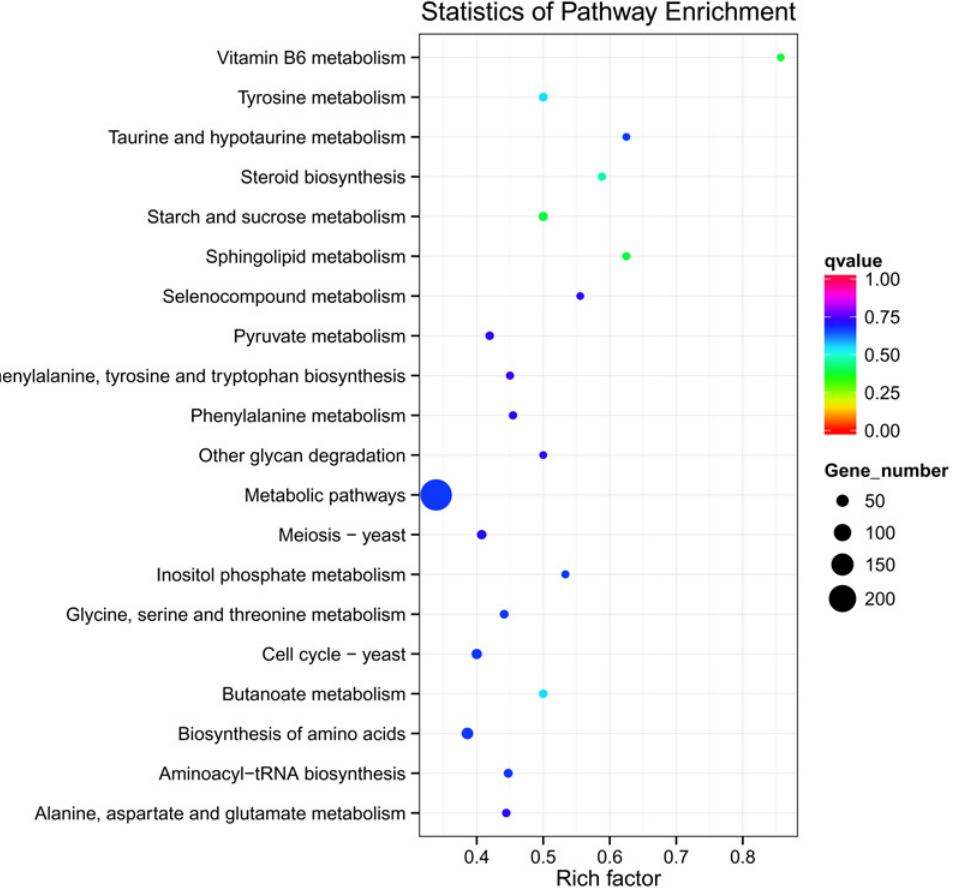
Fig 4. Statistics of KEGG pathway enrichment. The y-axis corresponds to KEGG Pathway, and the x-axis shows the enrichment factor. The color of the dot represent q value, and the size of the dot represents the number of DEGs mapped to the reference